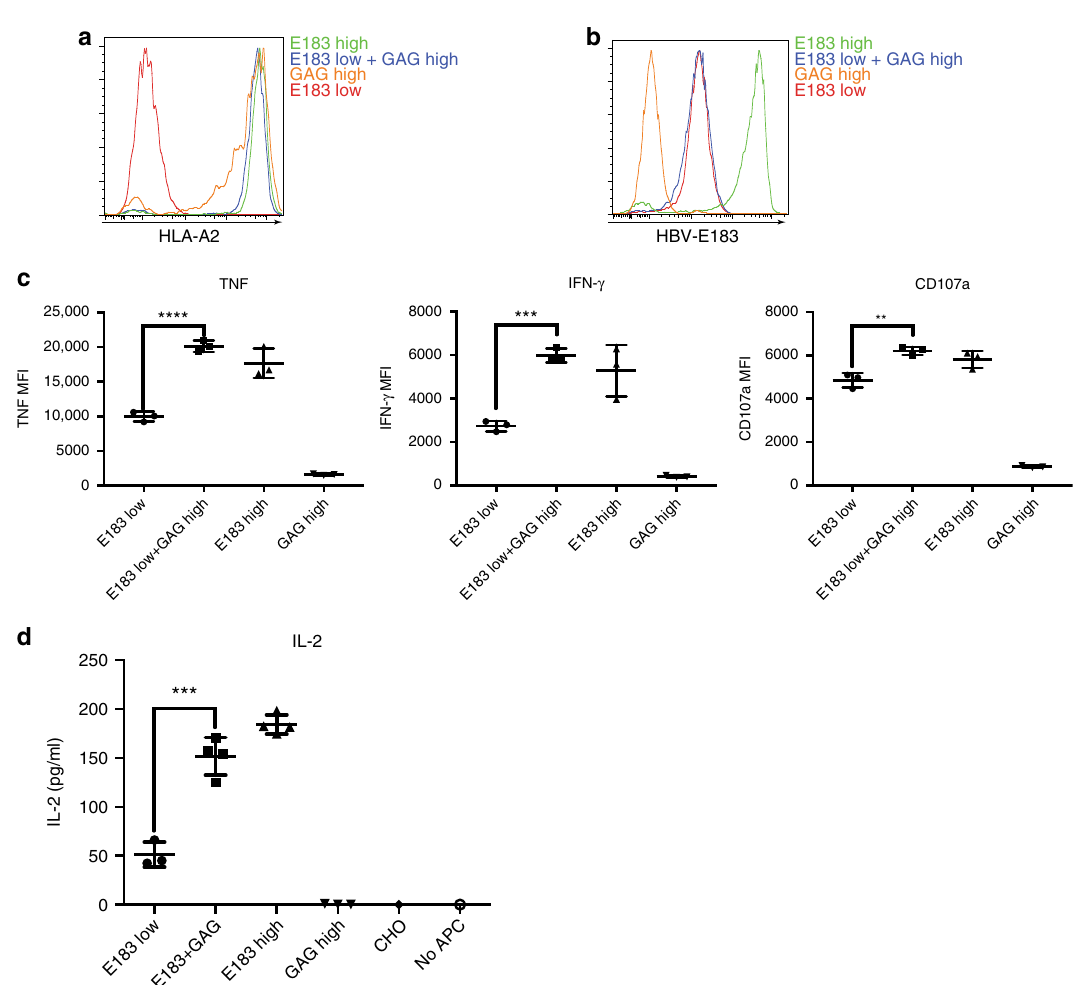
Fig. 2 Nonstimulatory pMHCI can enhance human CTL response to antigen. a Anti-HLA-A2 staining of T-REx CHO clones used in the coagonism experiments. b Measurement of the amount of the antigen, E183-HLA-A2 in T-REx CHO clones by staining with TCR-like antibody anti-E183-HLA-A2. c Human E183 CTL were cultured with the indicated T-REx CHO clones panel for 3 h and cytokine expression (TNF and IFN- γ ) and upregulation of the degranulation marker CD107a were assessed by fl ow cytometry. d Human E183 CTL were cultured with the indicated T-REx CHO clones panel for 24 h, and the amount of IL-2 in the supernatant was assessed by ELISA. Statistical signi fi cance was determined by using unpaired two-sided Student ’ s t test and shown as mean ± s.d. ( * p < 0.05, ** p < 0.01, *** p < 0.001). Data are representative of fi ve independent experiments. MFI mean fl uorescence